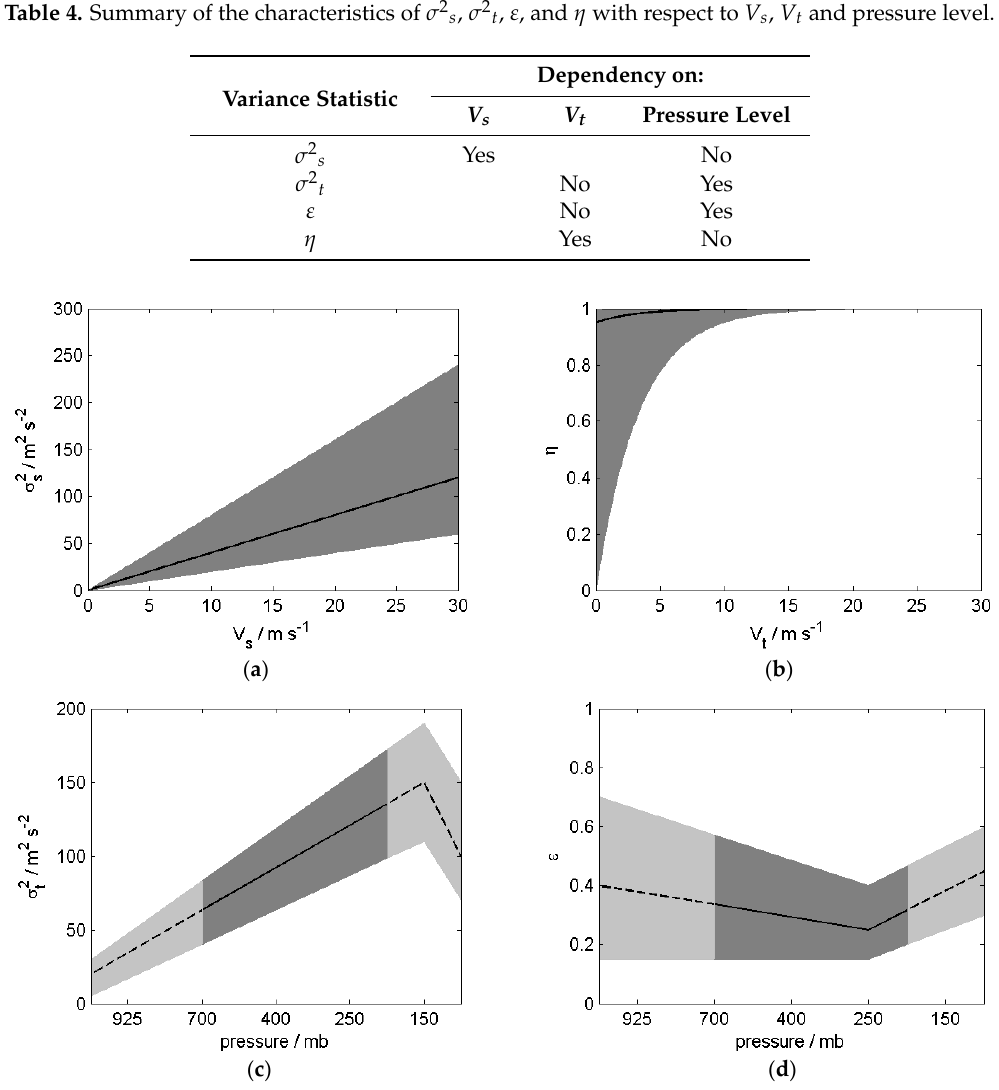
Figure 14. Qualitative illustrations of the observed trends summarised in Table 4. The black lines represent the median value whereas the shaded grey areas depict the spread. In ( c , d ), the areas of darker shade with the solid median line represent the mid-troposphere between the 700 mb and 200 mb pressure levels where the results in Table 4 were shown to be valid. ( a ) σ 2 s vs. V s ; ( b ) η vs. V t ; ( c ) σ 2 t vs. pressure level; ( d ) ε vs. pressure level.